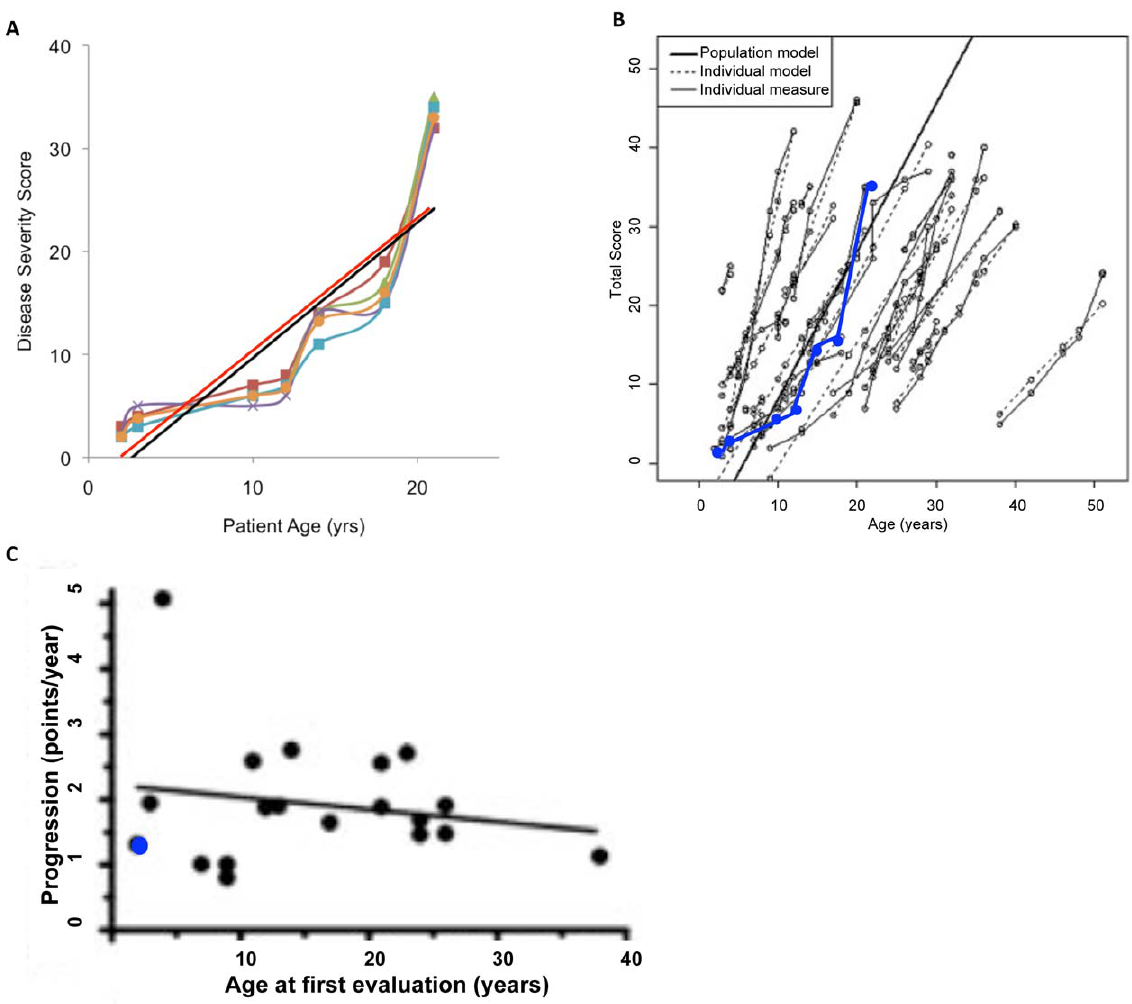
Figure 2. Initial assessment of one NP-C patient medical record by five students in Spring 2009. A. Five students independently scored one NP-C patient’s medical record, The disease severity curves were plotted as shown. The correlation among their evaluation is 0.76. The best fit line is shown in black line with a slope of 1.315. In red is the best fit line (with a slope of 1.3 and a correlation of 0.90) obtained by Yanjanin et al. 2010. B. The average of five student scores (show in blue) was overlaid on a summary of disease severity curves obtained by Yanjanin et al 2010 (obtained by combining their historical and current cohorts). C. The progression slope shown in panels A and B was determined by linear regression and overlaid (blue dot) onto the progression slope created by Yanjanin et al.